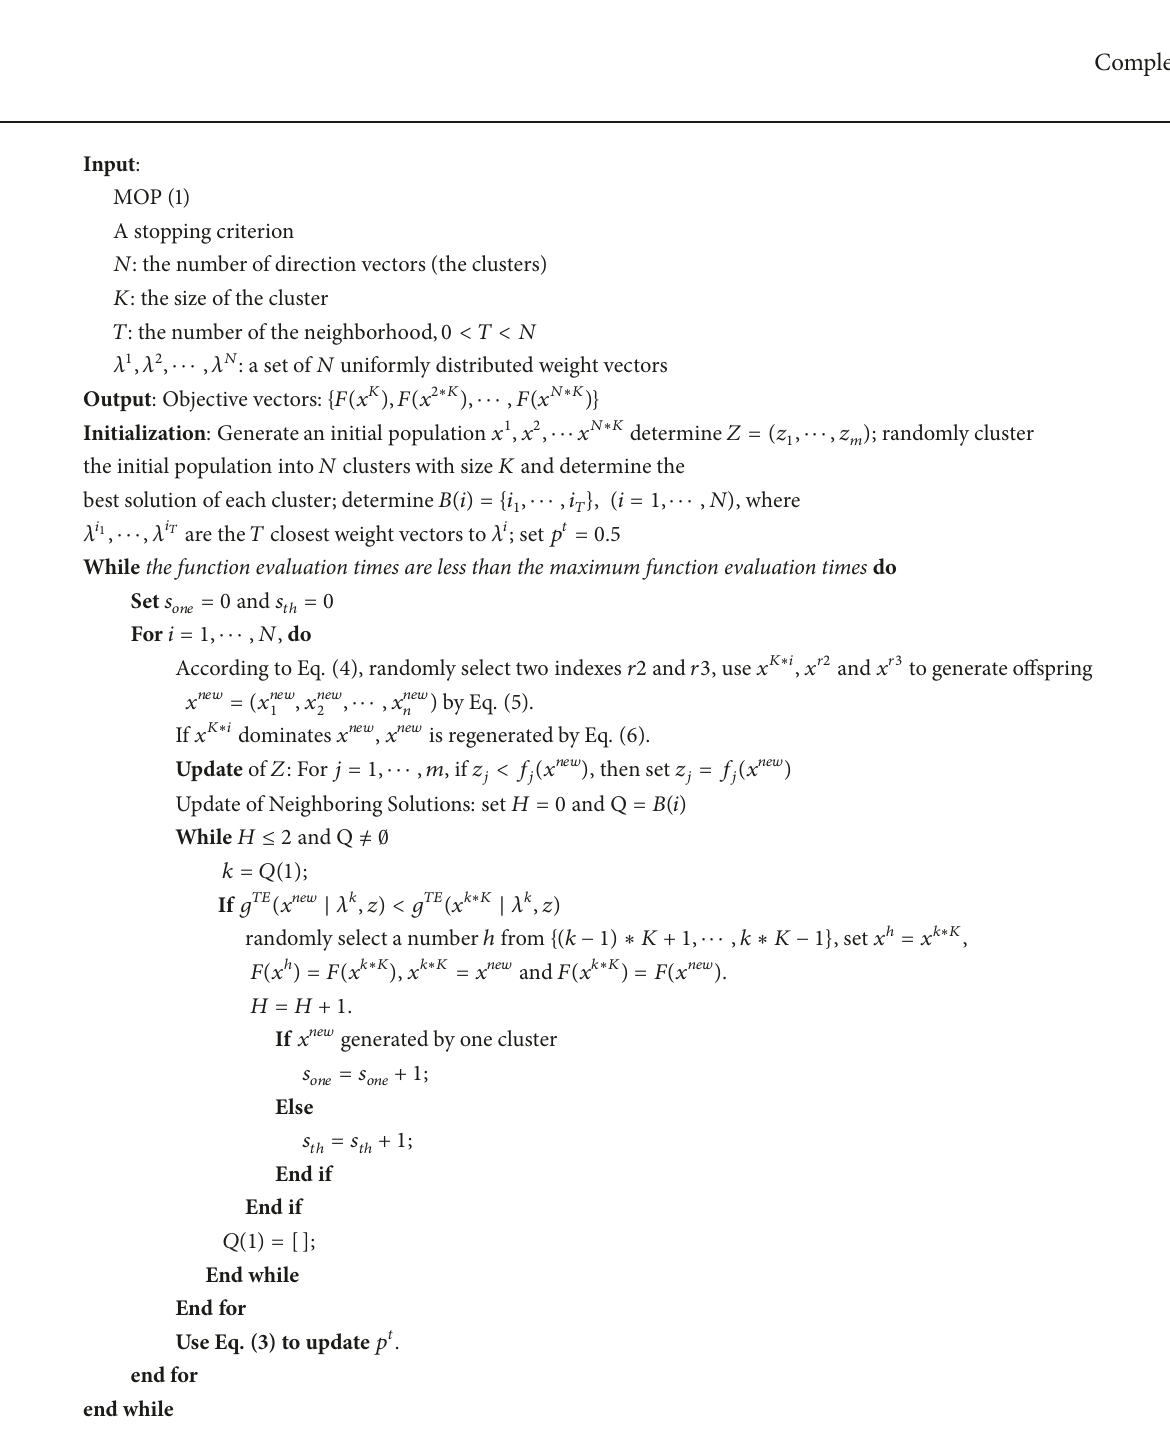
Pseudocode 2: The pseudo code of the algorithm